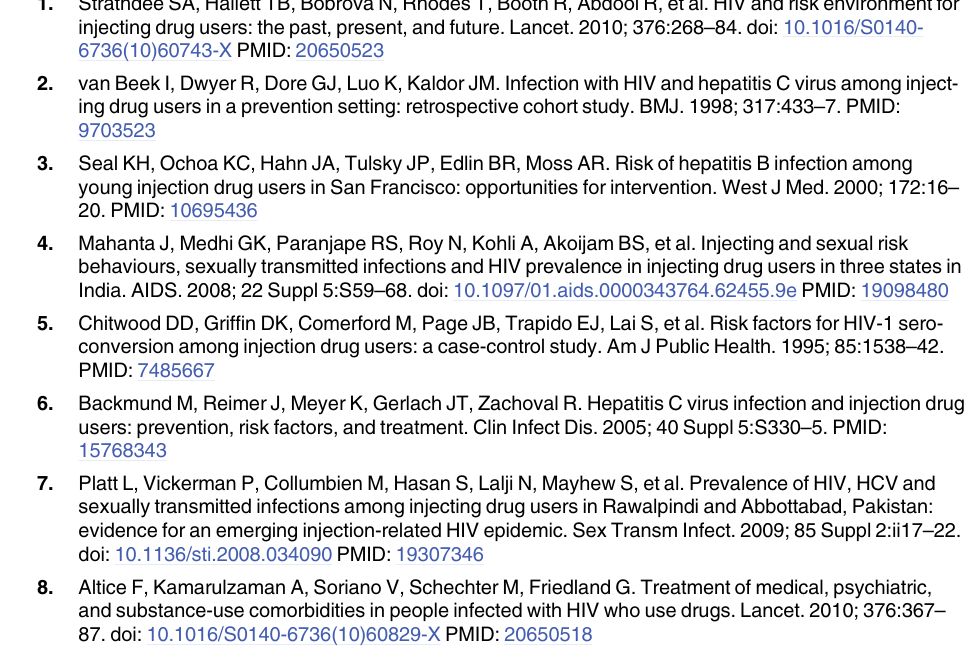
S2 Table. Injecting and sexual behaviors of participants stratified by integrated MAT